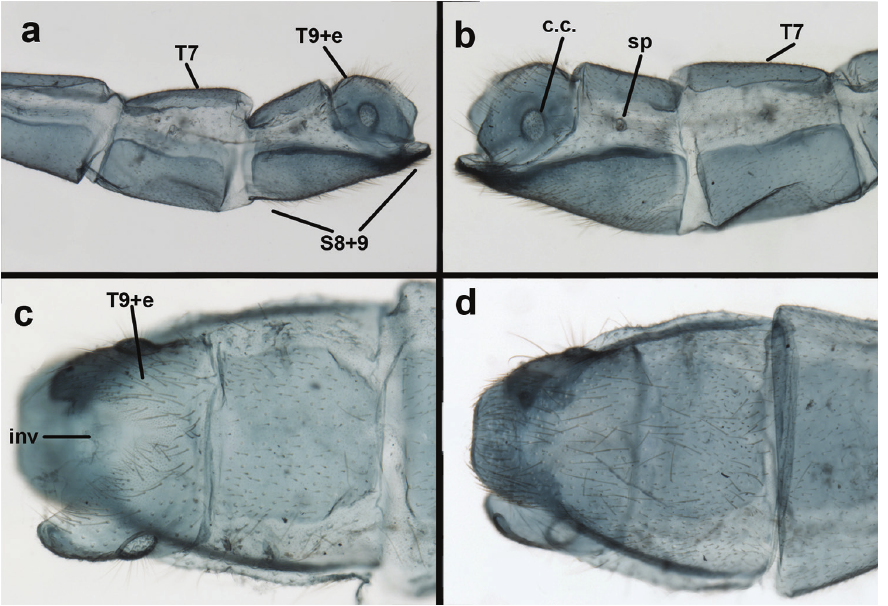
Figure 66. Ungla nigromaculifrons Sosa: Male abdomen, ( a ) segments A6-terminus, lateral ( b ) segments A7-terminus, lateral ( c ) T8, T9+ectoproct, dorsal ( d ) sternite 8+9, ventral. c.c. callus cerci inv invagi- nated dorsal cleft in T9+ectoproct sp spiracle S8+9 fused eighth and ninth sternites T7 seventh tergite T9+e ninth tergite + ectoproct (Venezuela, Táchira,